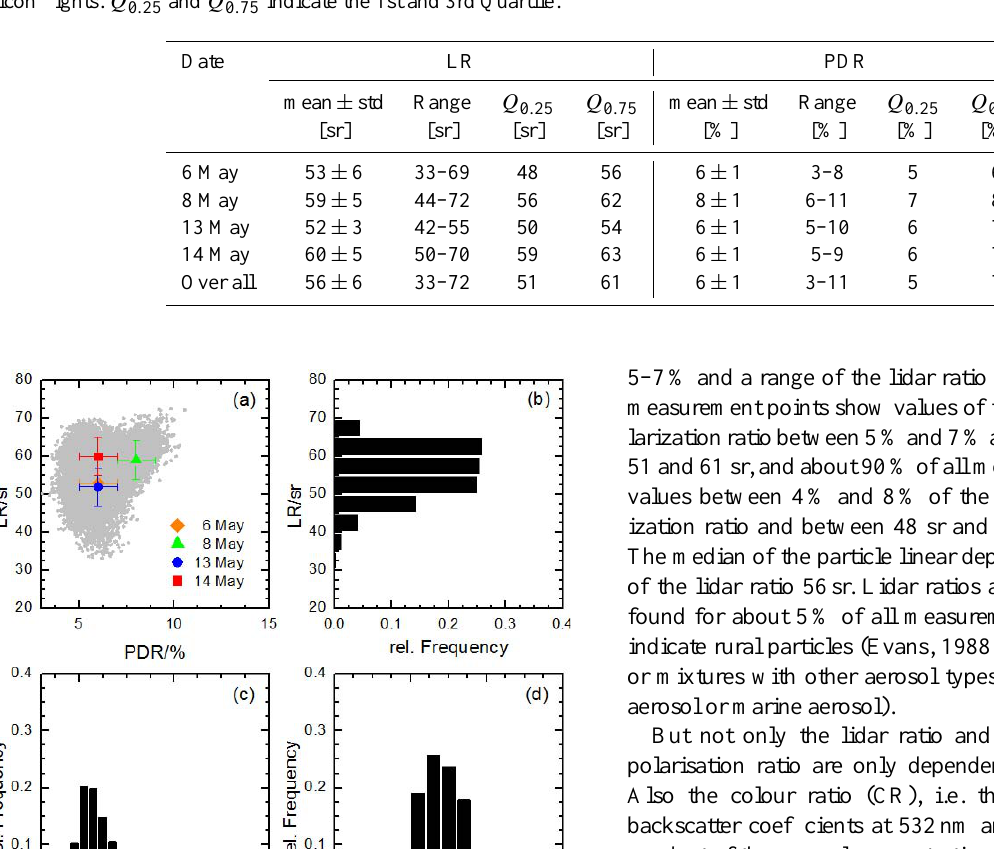
Table 2. Lidar ratio (LR) and particle linear depolarisation ratio (PDR) at 532nm, and their statistical information determined from analysed Falcon flights. Q 0 . 25 and Q 0 . 75 indicate the 1st and 3rd Quartile.